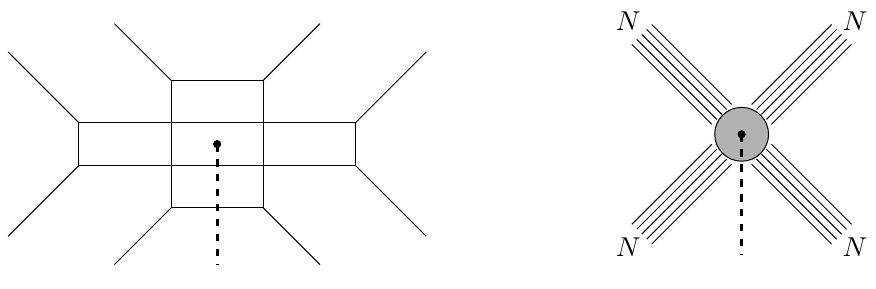
Figure 6 . Brane web and intersection with a large- N limit. On the right hand side the conformal limit for generic N , on the left hand side for N = 2 a deformation corresponding to (cid:12)nite gauge coupling and a state on the Coulomb